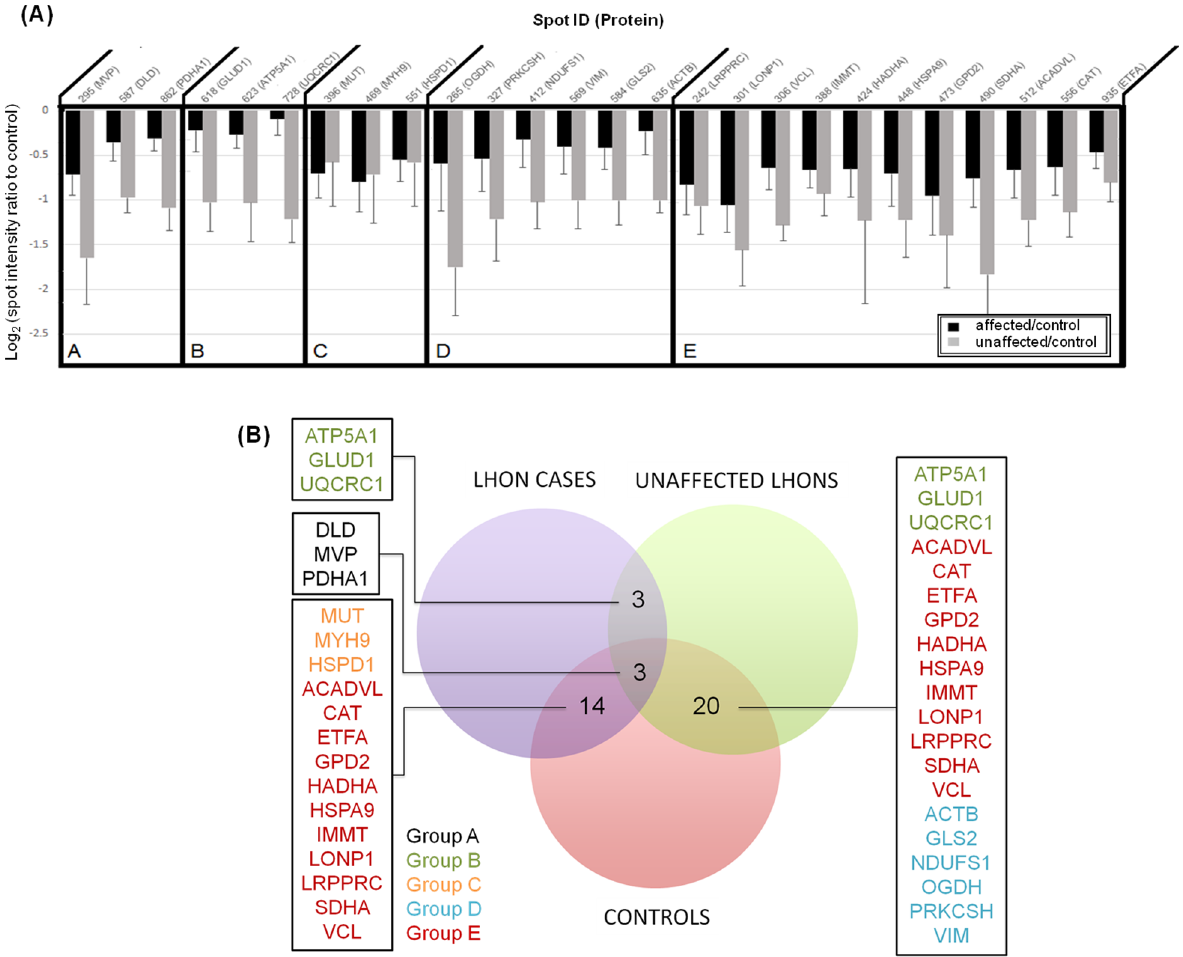
Figure 7. (A) A plot of log-ratio spot intensities, comparing affected individuals (black bars) and unaffected relatives (grey bars) versus controls. Log-ratios of protein spot intensities were plotted according to the method of [63]. In the case that one protein was identified in several spots, the only spot intensity that gave the highest significant value was selected for this plot. Negative changes were observed in all discoveries. Group A includes protein spots which were significantly differentially expressed in comparisons of affected and unaffected carriers, affected individuals and controls, and unaffected individuals and controls (Post Hoc Tukey Test; P -value , 0.05). Group B includes protein spots which were significantly differentially expressed in comparisons of affected and unaffected carriers, and between unaffected carriers and controls. Changes between affected individuals and controls were not significant. Group C includes protein spots which were significantly differentially expressed only in the comparison between affected individuals and control. Group D includes protein spots which were significantly differentially expressed only in the comparison between unaffected carriers and controls. Group E includes protein spots which were significantly differentially expressed the comparisons between affected individuals and controls, and between unaffected carriers and controls. Here, the differences in expression between affected and unaffected carriers are not significantly different. (B) Venn diagram representation of proteins identified in three comparisons derived from figure